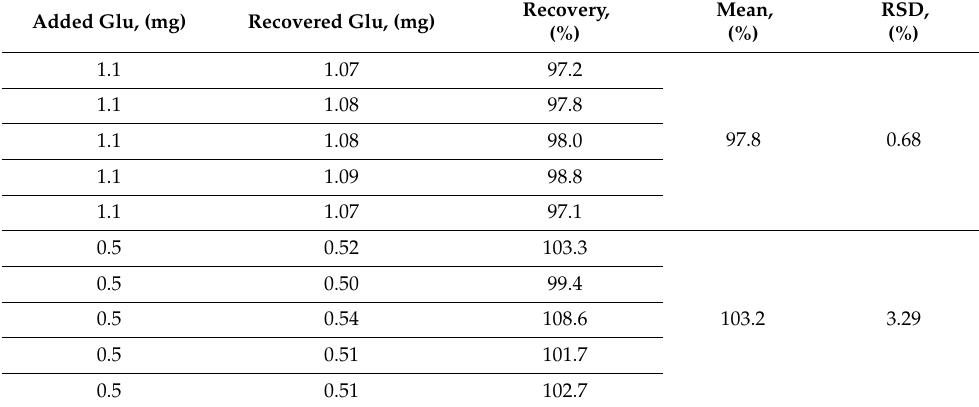
Table 1. Repeatability and accuracy for Glu in potato ( n = 5). Added Glu,